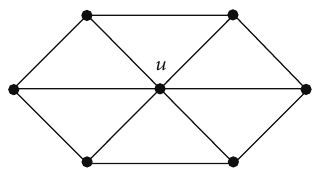
Figure 3: The wheel graph 𝑊 7 .